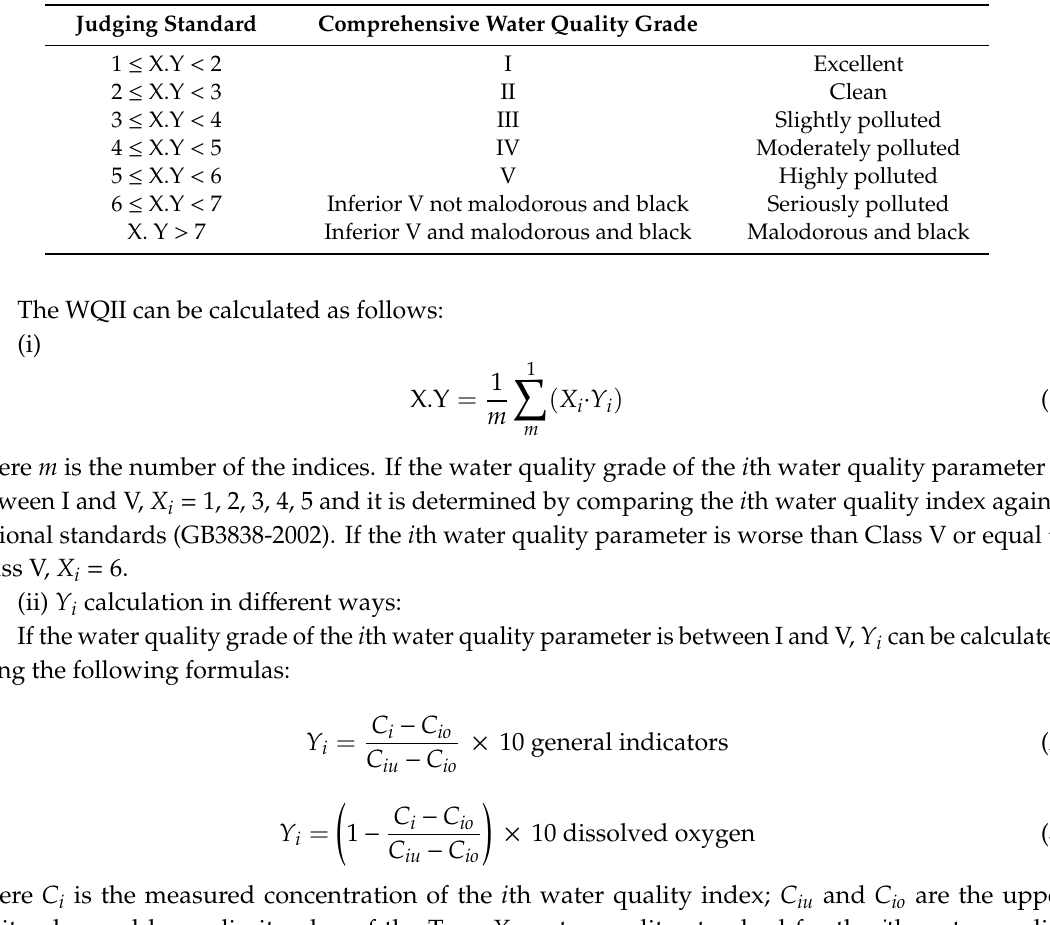
Table 3. Comprehensive water quality grade (Ma et al., 2014)